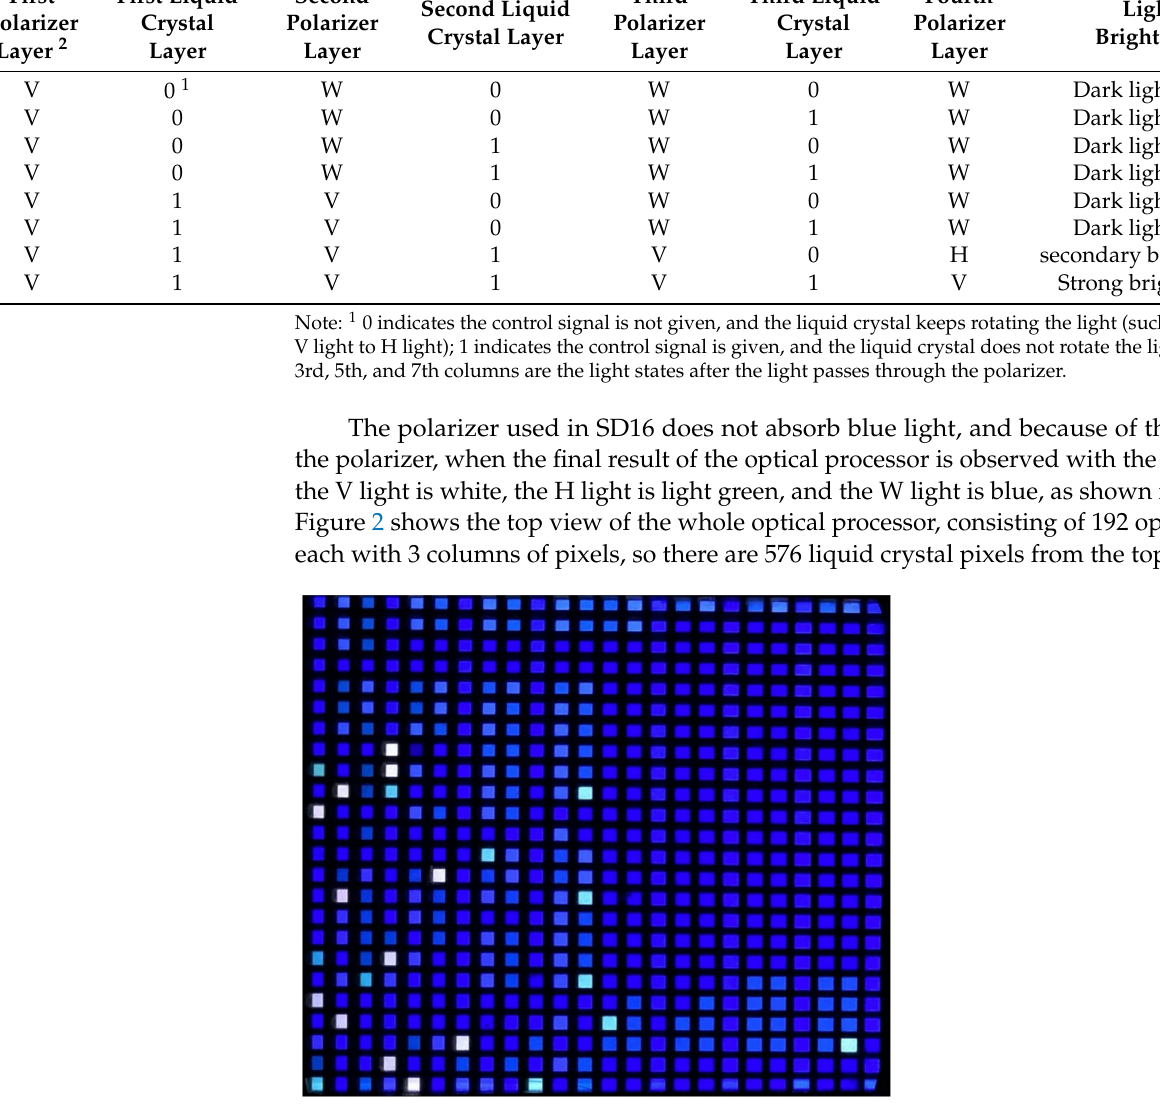
Table 1. Spin light mode, output light state, and light brightness comparison table.